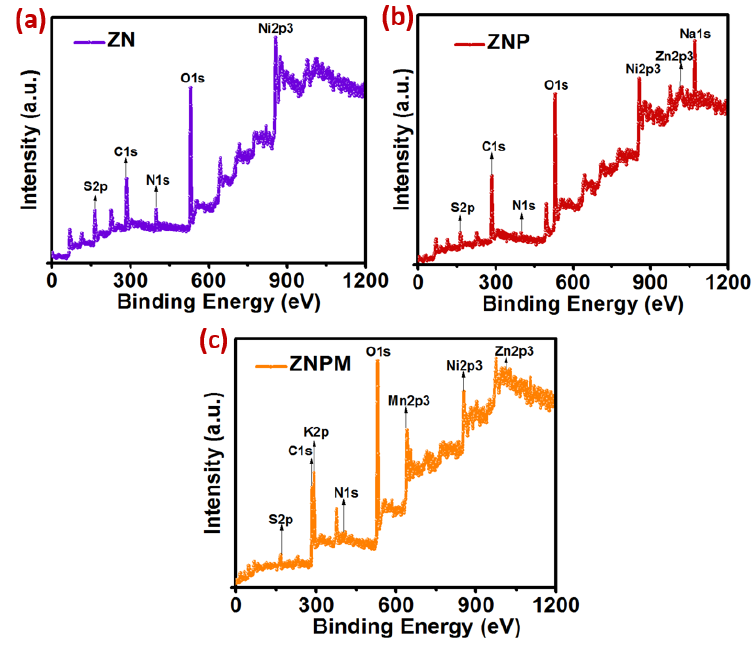
Figure 3. XPS survey spectrum of ( a ) ZN ( b ) ZNP and ( c ) ZNPM.